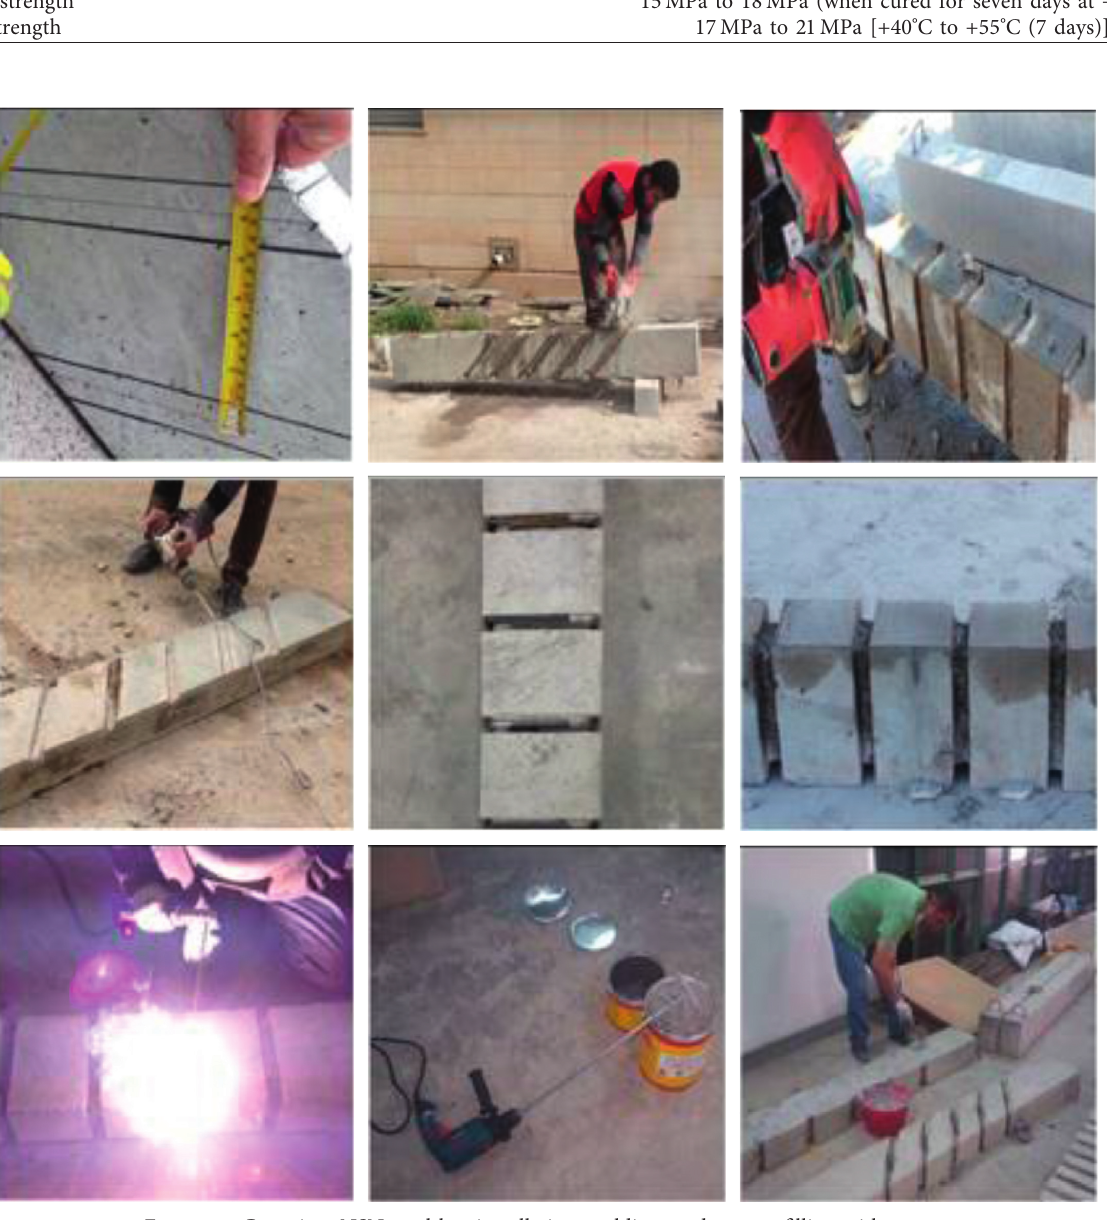
Figure 5: Grooving, NSN steel bar installation, welding, and groove filling with epoxy.